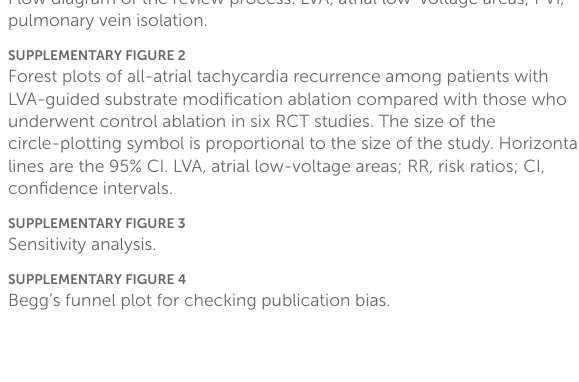
SUPPLEMENTARYFIGURE4 Begg’s funnel plot for checking publication